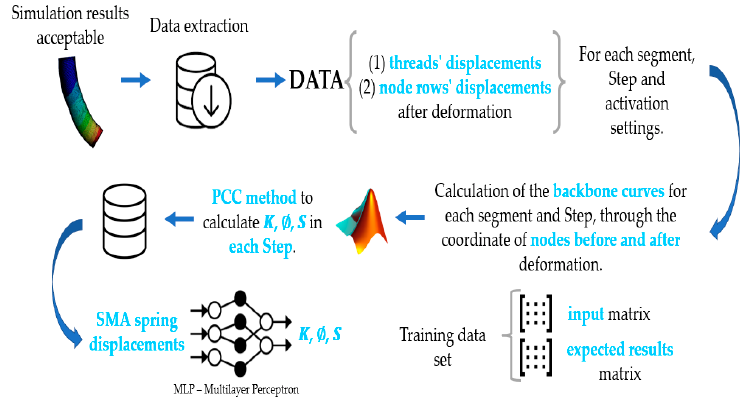
Figure 20. Scheme of the different phases that lead from the FEA simulation to neural network training. Source: authors [24].